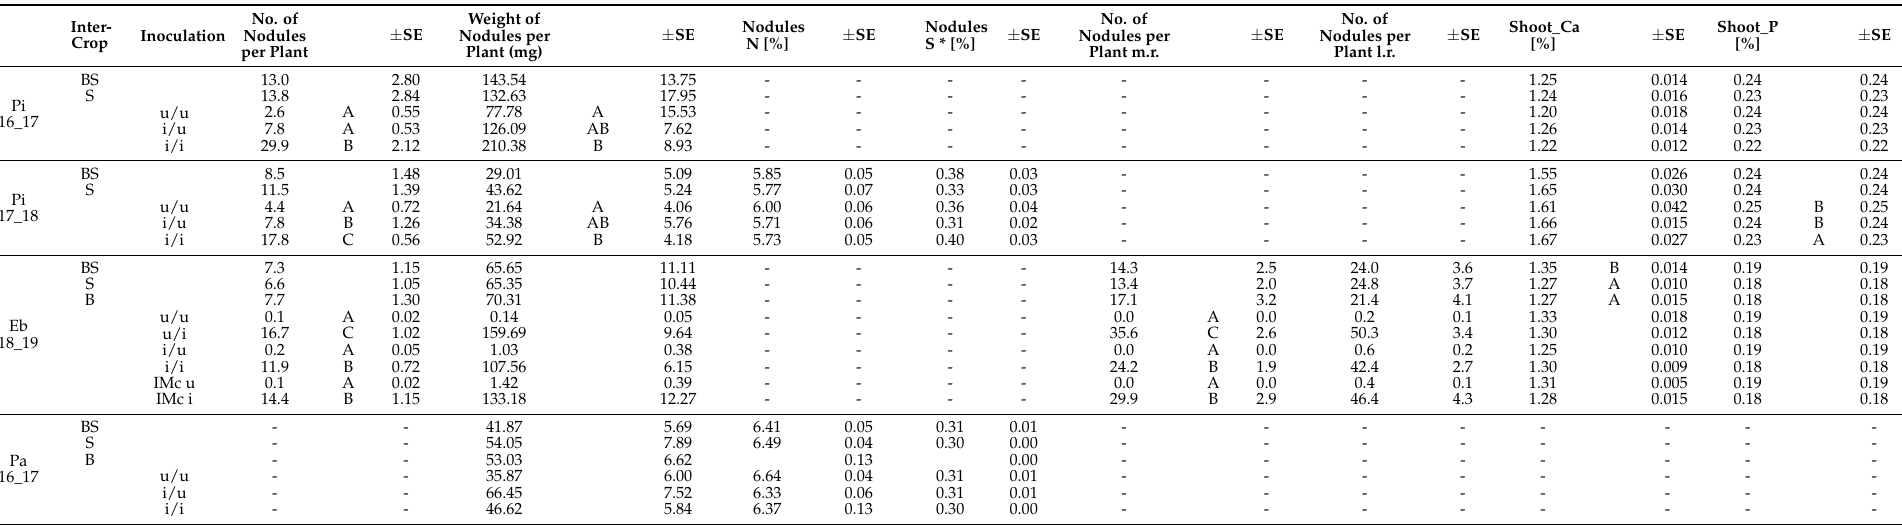
Table 5. Recorded nodule data and shoot nutrient content in the soybean main